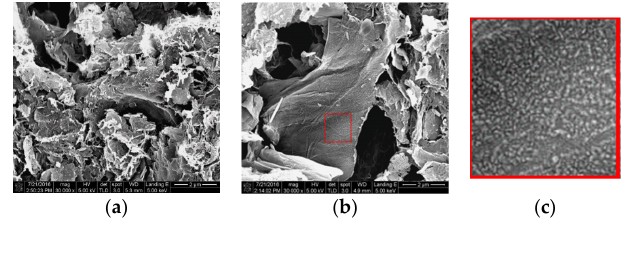
Figure 3. Plasma spectrum evolution during APPJ sintering on samples with added 100  L H 2 PtCl 6